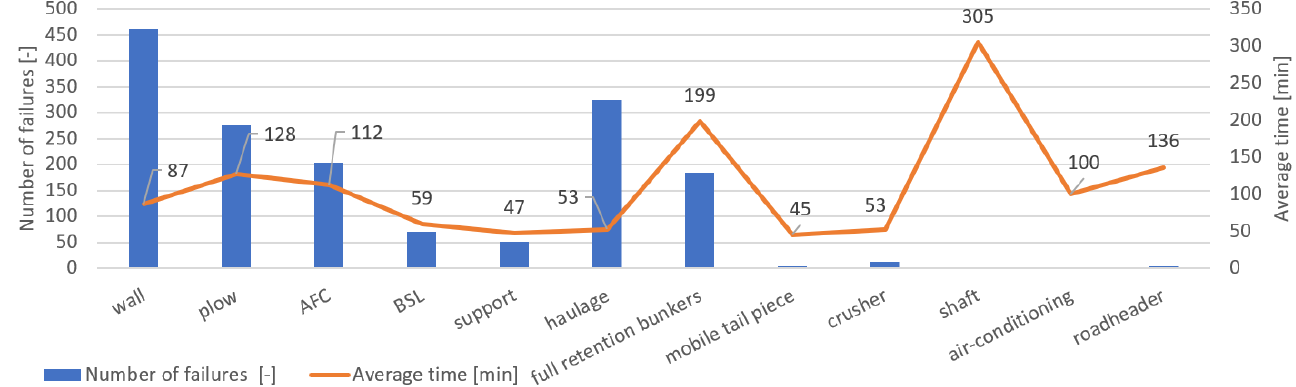
Figure 8. Number of failures and average duration of failures of plow longwalls in total.